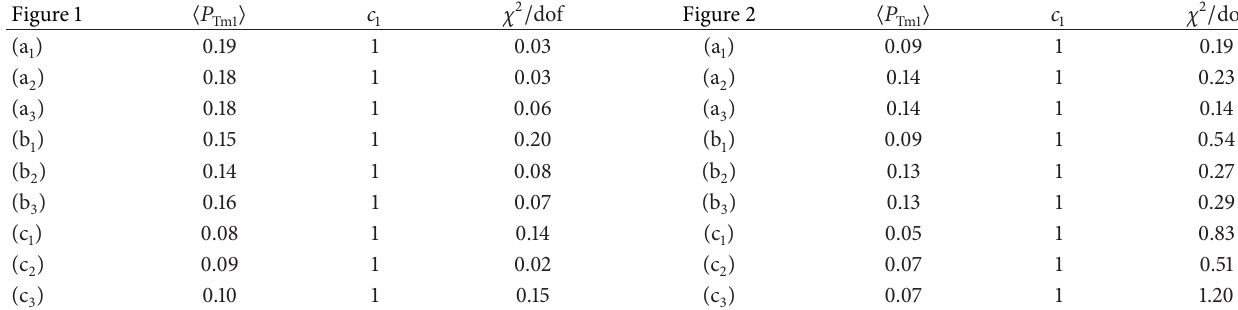
⟩ , 𝑐 1 taken in the fits of Figures 1 and 2. Tm1